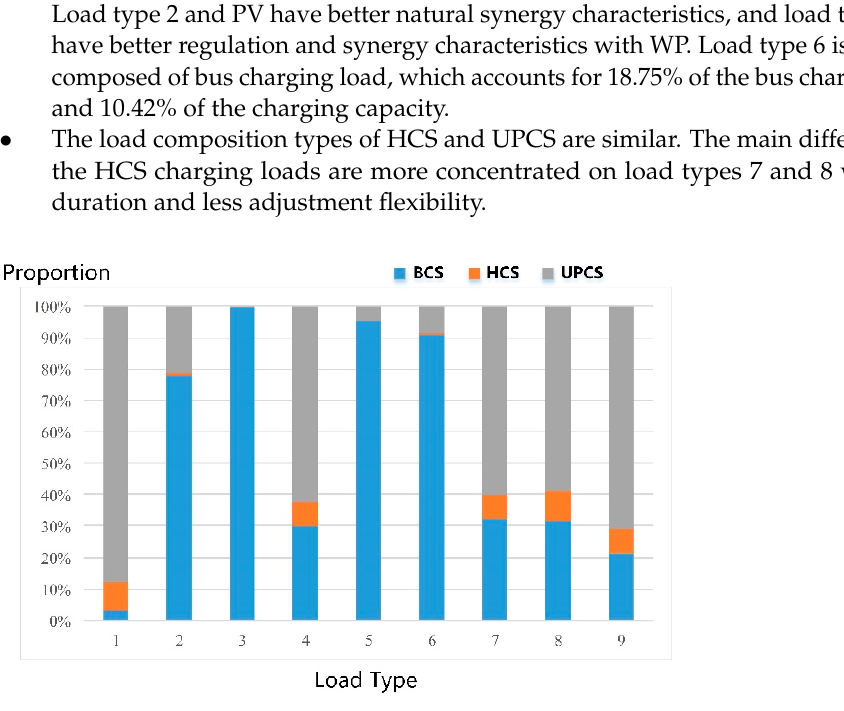
Figure 11. The proportion of different charging station types in different load types.